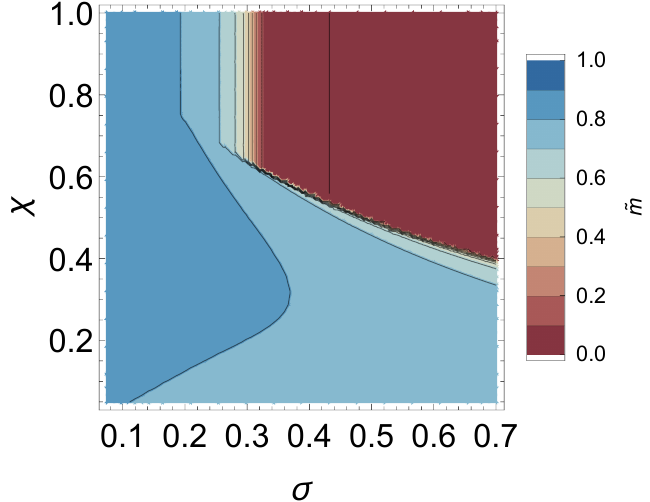
Figure 4. The scaled median ˜ m as a function of χ and σ . ˜ m is the median of the distribution of η relative to its range. ˜ m close to one indicates that the mass of the distribution is located near the upper dividend paying boundary. ˜ m close to zero indicates that the mass is located near the lower liquidation or recapitalisation boundary. σ 2 = 0.0 (the baseline value from earlier figures) so σ 1 = σ . Other parameters were set to baseline values; ρ = 0.06, r = 0.05, a = 0.1, ¯ a = 0.04, δ = 0.02 and θ = 15. Contours are plotted at level values of ˜ m and are spaced at intervals of